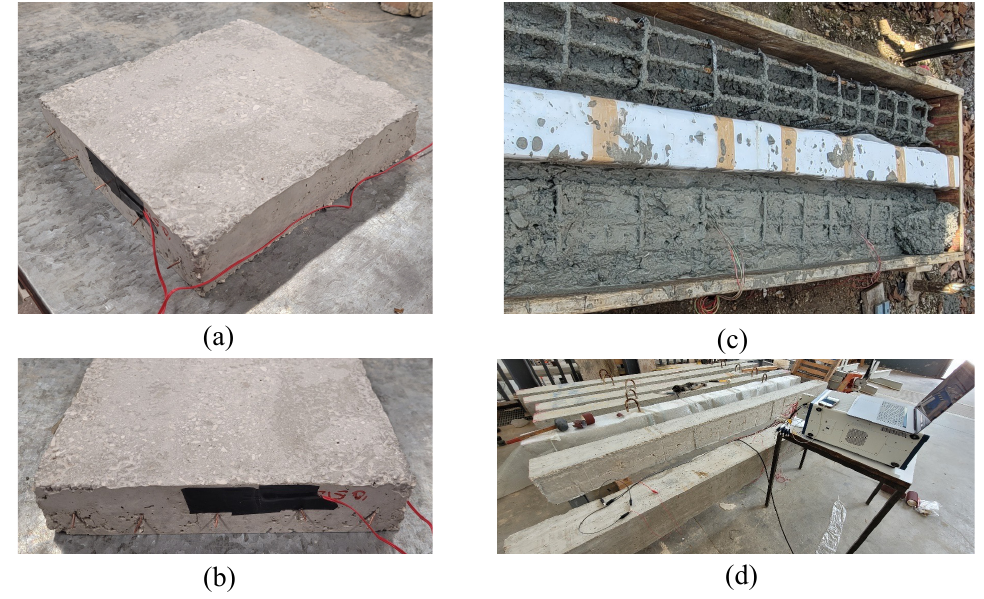
Figure 4. Medium- and full-scale samples: ( a , b ) plate with linear embedded electrodes; ( c ) beams during preparation; ( d ) beams after the curing period.